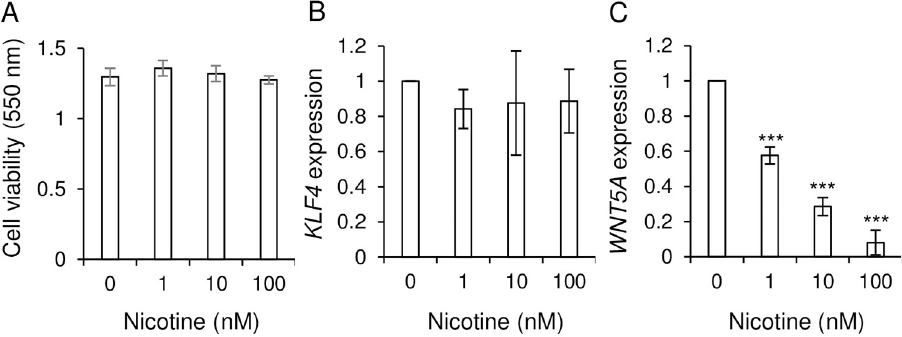
Fig 4. Nicotine decreased Wnt5a expressions in SK-BR-3 cells. (A) Cell viability of SK-BR-3 cells with nicotine treatment (0–100 nM) was measured by MTT assay (n = 4 each). (B, C) KLF4 (B) and Wnt5a (C) mRNA expressions in SK-BR-3 cells at 24 h after nicotine treatment were measured by qPCR (n = 4 each). Each mean ± SEM is shown. ��� p < 0.001.